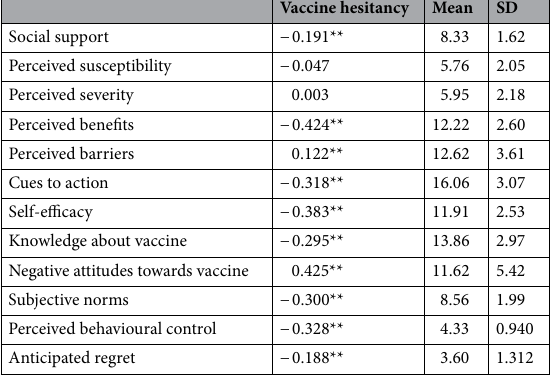
Vaccine hesitancy Mean